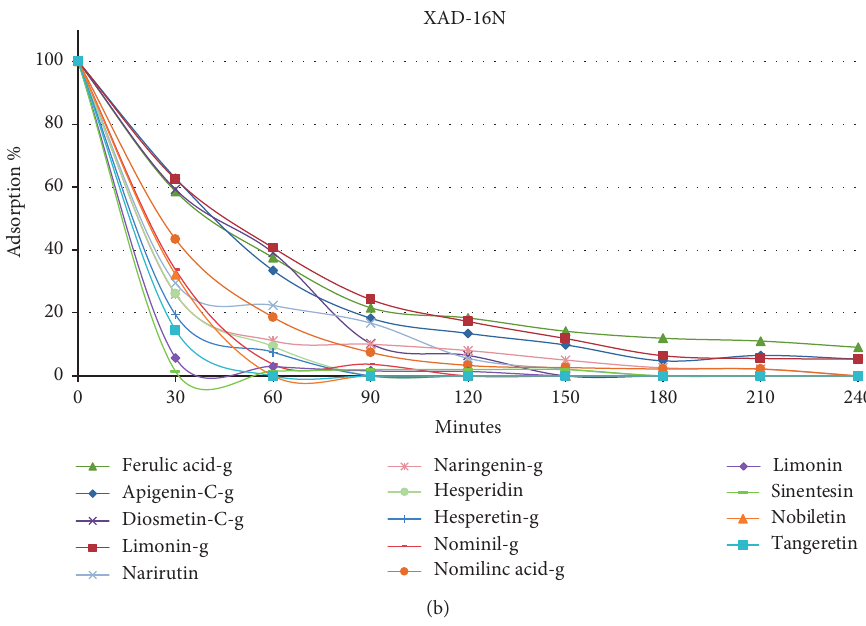
Figure 2: Adsorption kinetics of analytes using XAD-4 and XAD-16N macroporous